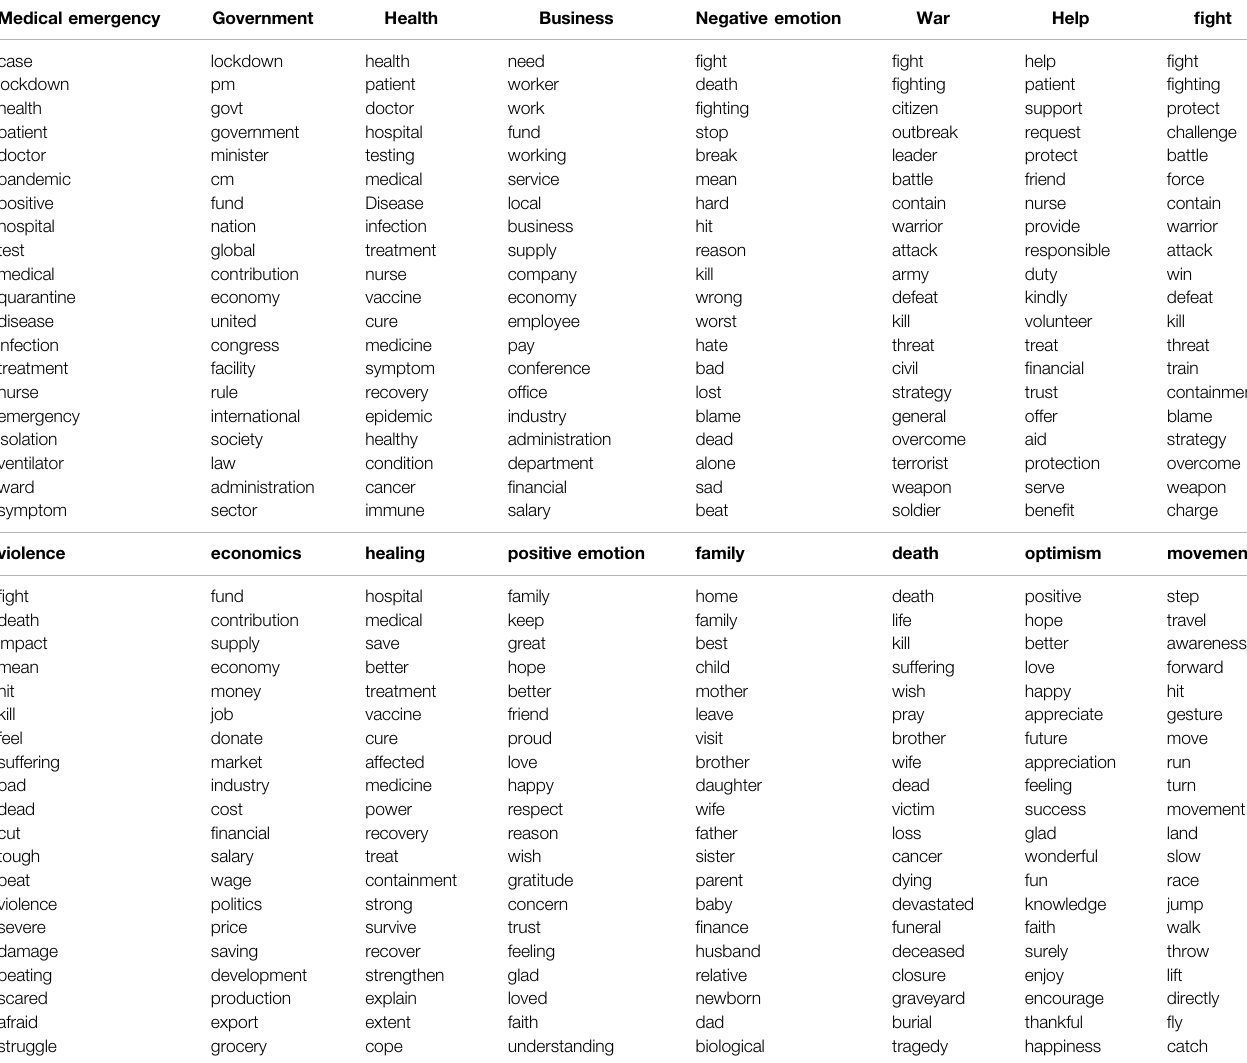
TABLE 4 | The top 20 most frequently occurring words for each empath category which had a score of > 0.01 in the national level tweets analysis. Medical